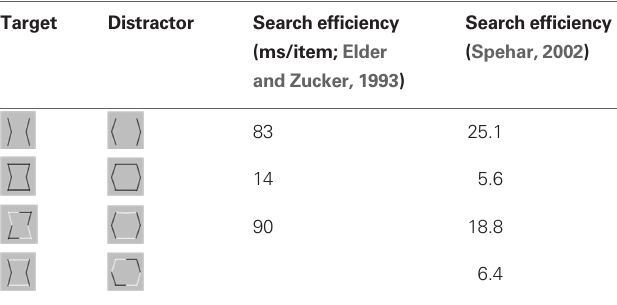
Table 1 | Dependency of search performance on